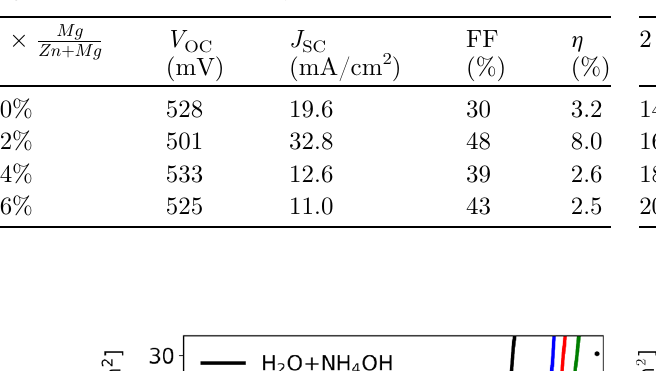
Table 2. PV parameters of devices with KCN and OH surface treatment, see Figure 2b. Percentages NH 4 correspond to the Mg content of the buffer layer.